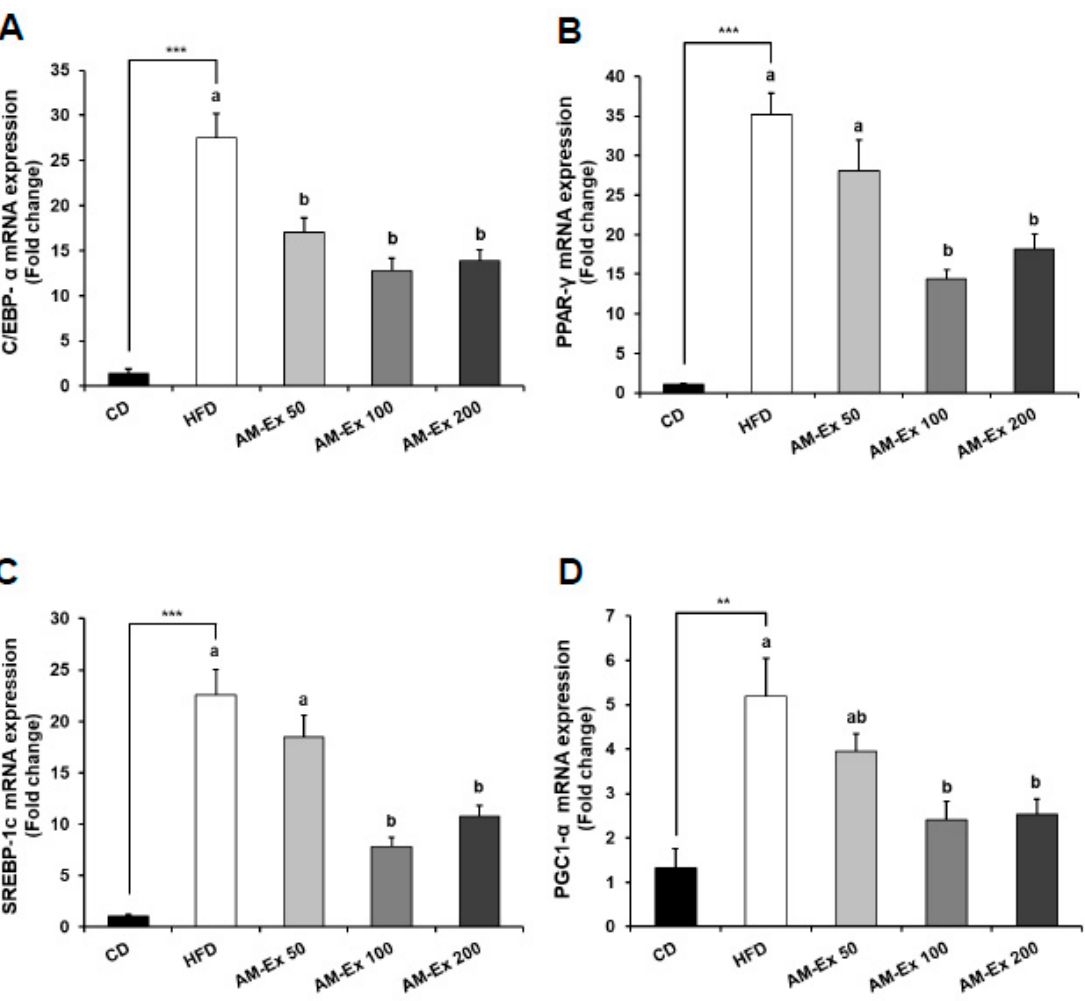
Figure 4. Effect of AM-Ex administration on the expression of adipogenic transcription factors in epididymal adipose tissue of HFD-fed C57BL/6N mice. AM-Ex was administered by oral gavage for eight weeks while the mice were fed the HFD. The total RNA in epididymal adipose tissue was isolated, reverse transcribed, and real-time PCR was conducted. The amount of each messenger RNA (mRNA) was normalized to the amount of glyceraldehyde 3-phosphate dehydrogenase (GAPDH) mRNA and expressed relative to the CD group. Each bar represents the mean ± SEM (n = 10). * P < 0.05, ** P < 0.01, *** P < 0.001 significantly different from the CD group. Means without a common letter differ between HFD, AM-Ex 50, AM-Ex 100, and AM-Ex 200 groups at P < 0.05.